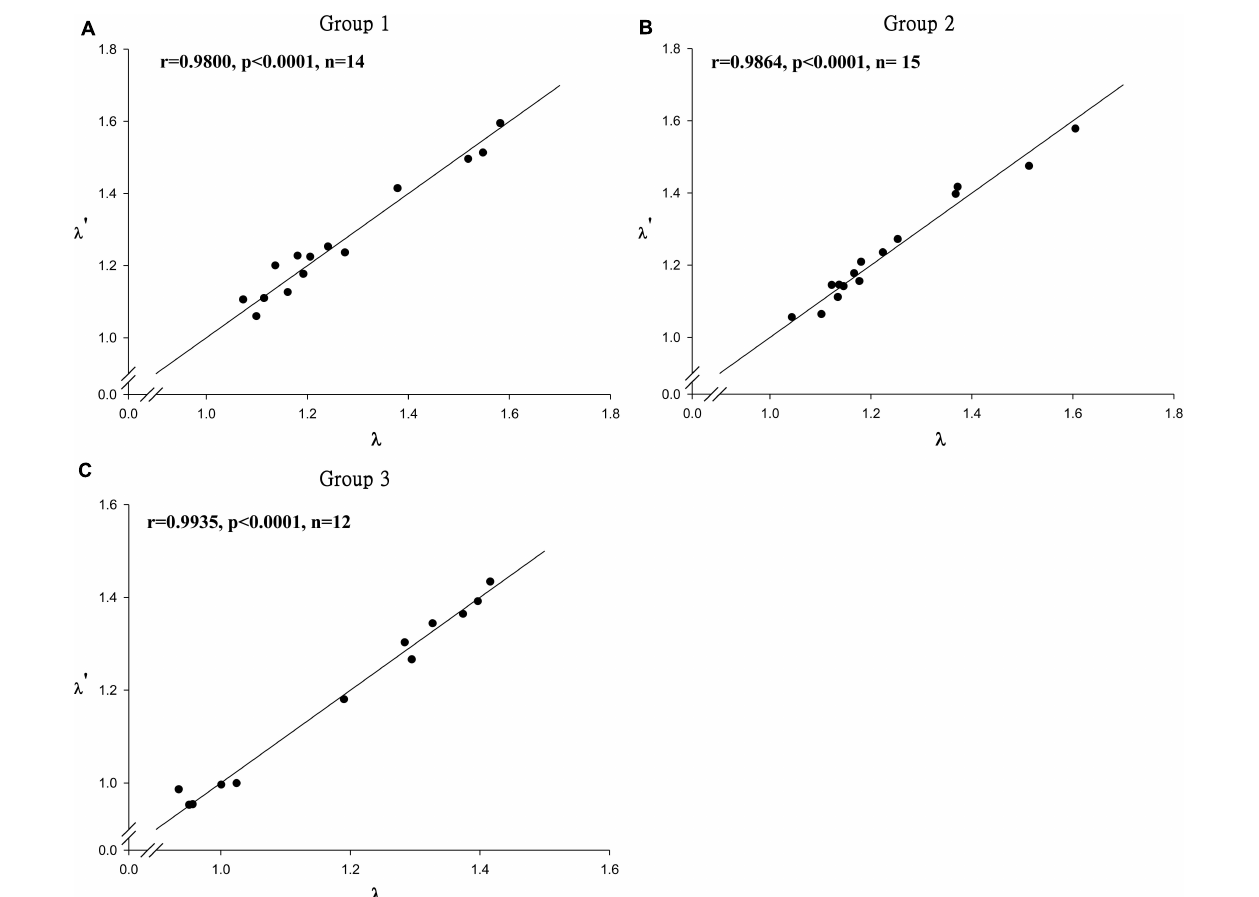
additional empirical equations such as Jensen (1996);